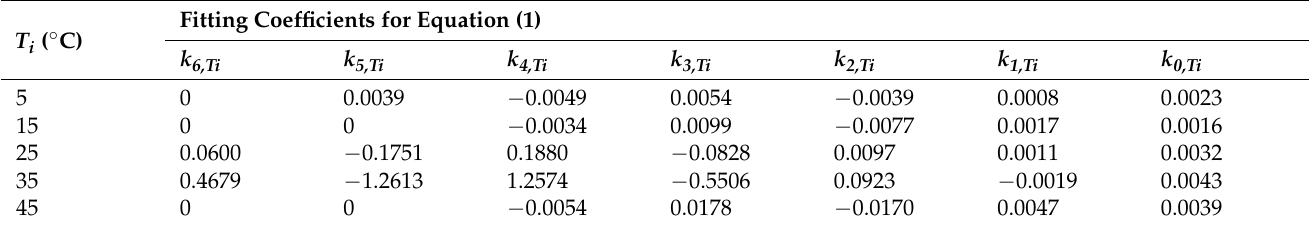
Table 2. Six-order polynomial fitting coefficients in Equation (1) for the calculation of internal resistance R T ( Ω ) at different battery temperatures T i i